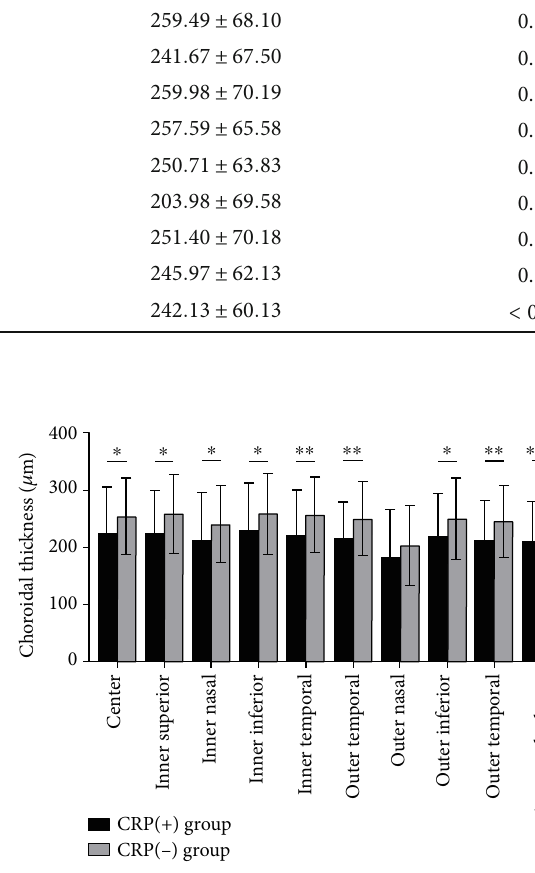
± 68 : 93 μ m in the CRP (+) group and 242 : 13 ± 60 : 13 μ m